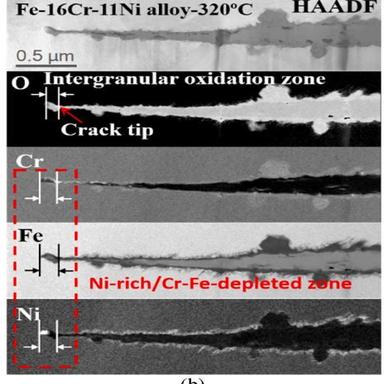
HAADF images and qualitative EELS elemental maps of representative SCC crack tips prepared from Fe-16Cr-11Ni alloy tested at (a) 360 ◦C and (b) 320 ◦C.